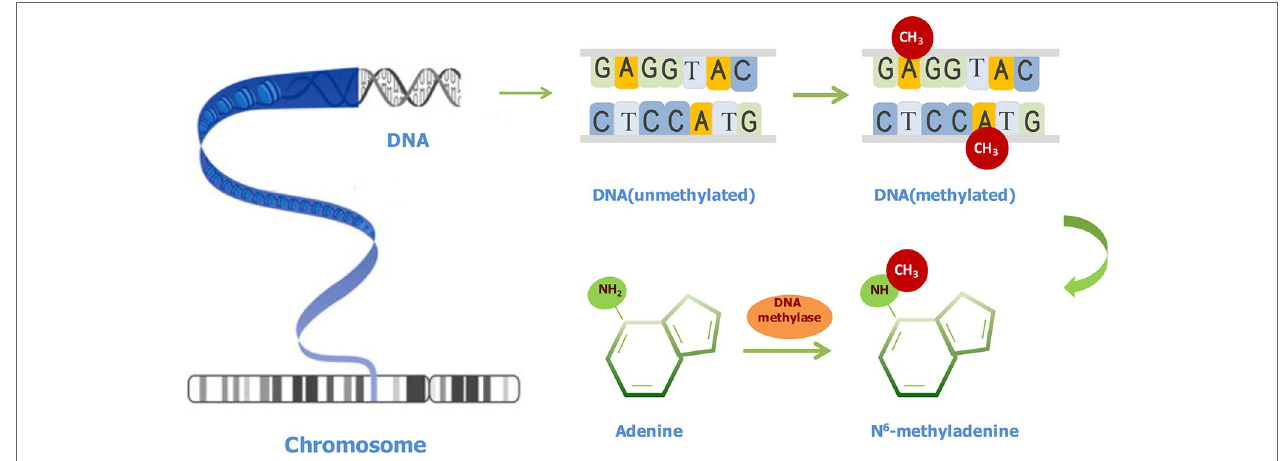
FIGURE 1 | Illustration of N6-methyladenine (6mA) modifications in DNA. The conversion of adenine to 6mA is mediated by